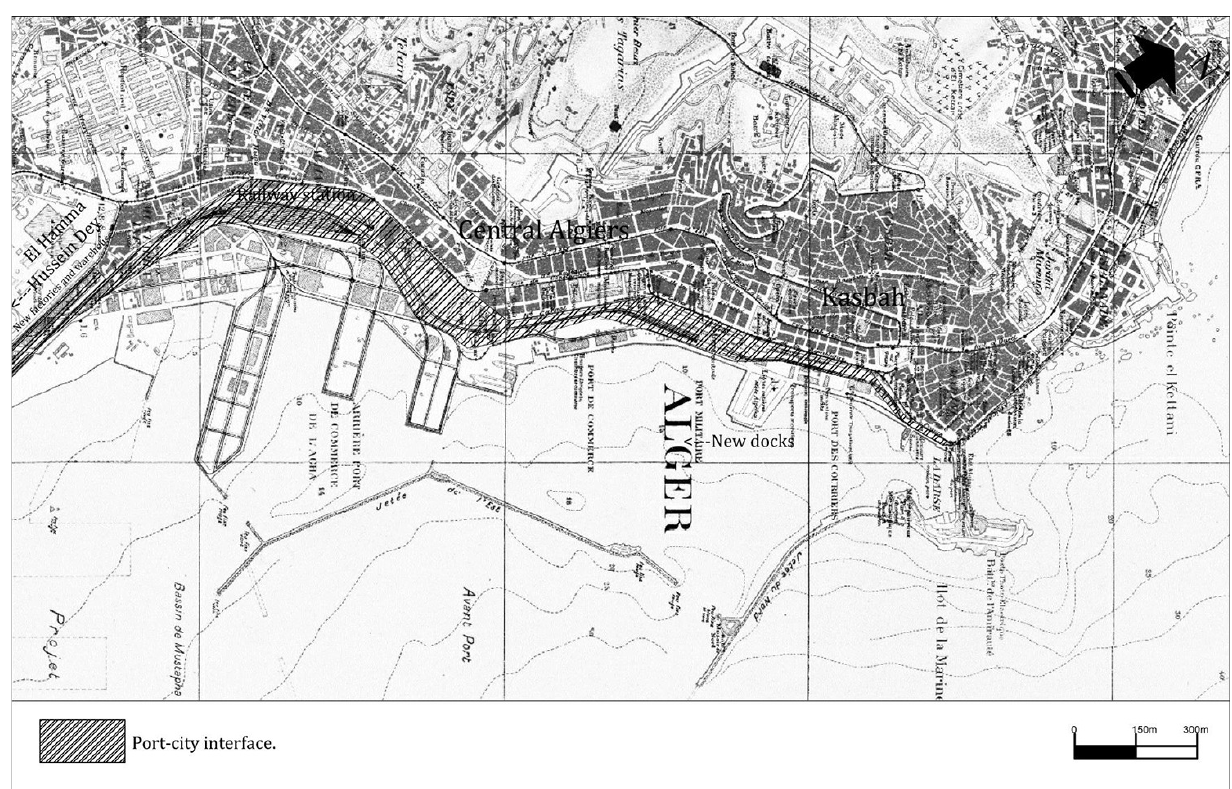
Figure 6. Map of Algiers in 1925, accentuating the structure of the port‐city interface. Source: Amended by the authors, based on Farnet